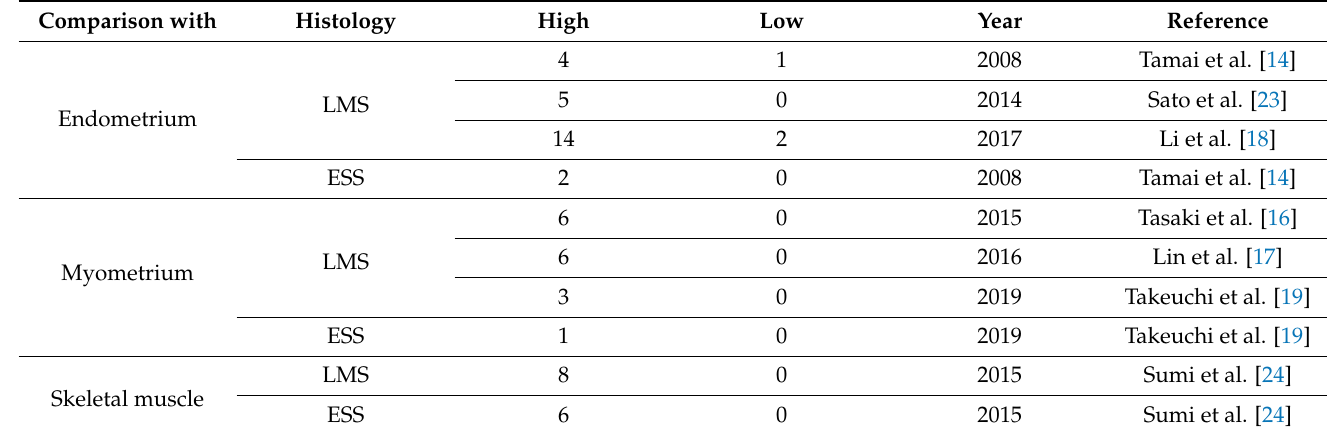
Table 3. The signal intensity of uterine sarcoma for